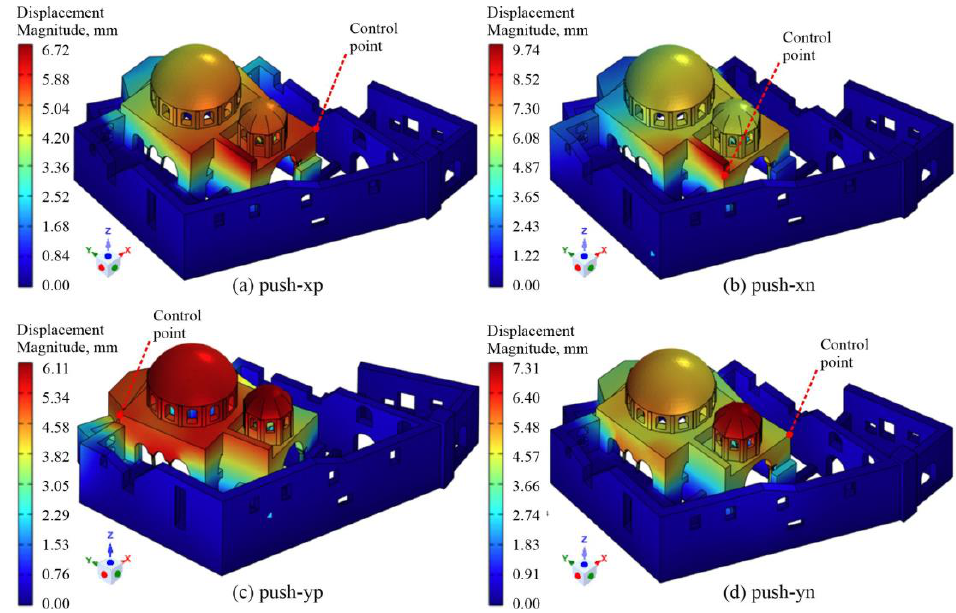
Figure 17. Displacement contour of the main structure at ultimate strength under lateral loads.